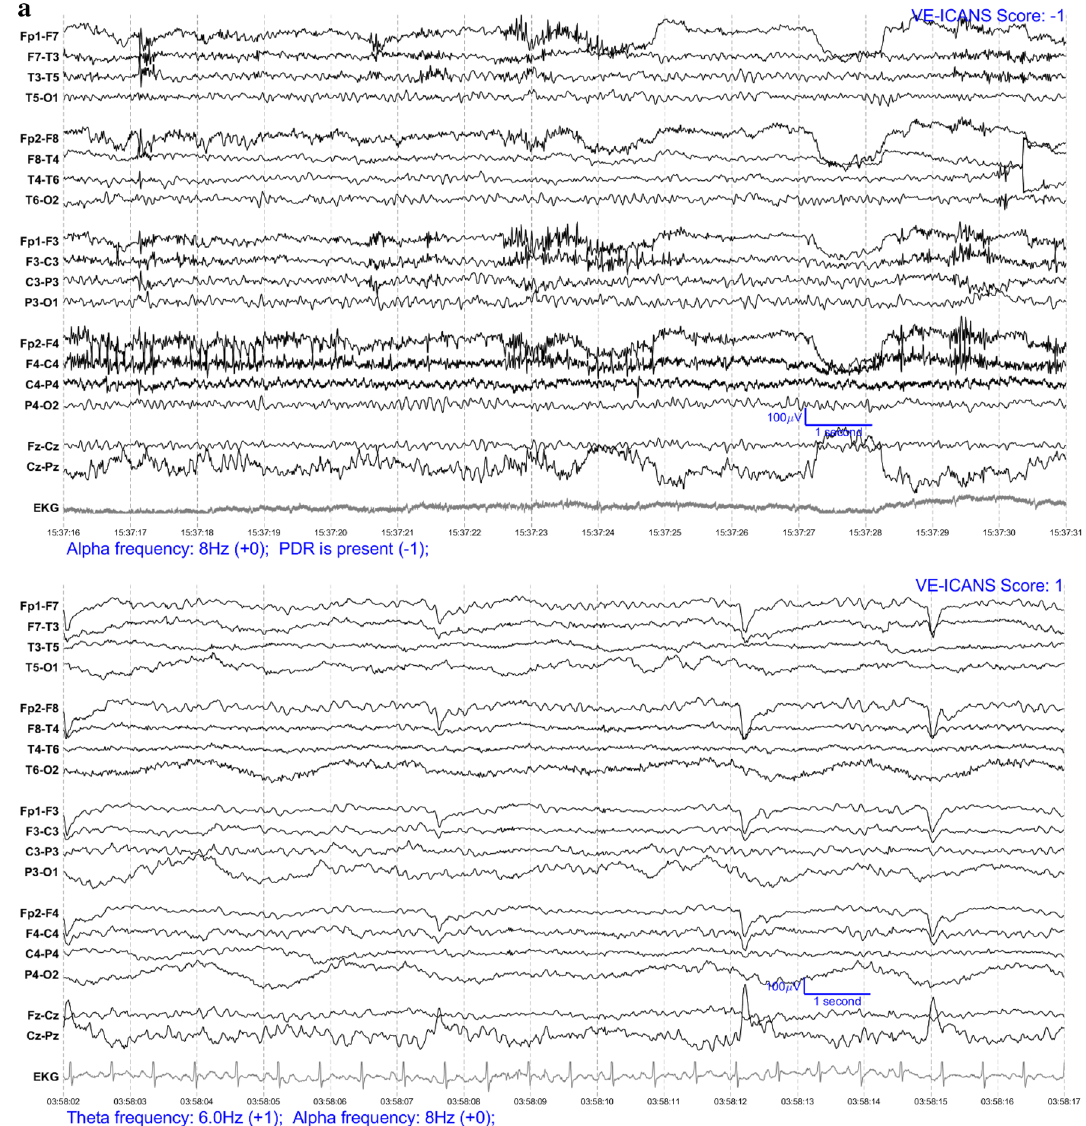
Figure 1. EEG examples from patients who recently received CAR-T therapy (in Bipolar Montage format). The VE-ICANS score given to each image by the VE-ICANS model is shown in the upper right corner. The graded features that contributed to that score are shown in the bottom left along with their point values. ( a ) Example EEGs for mild/no ICANS. ( b ) Example EEG for moderate ICANS severity. ( c ) Example EEG for high ICANS